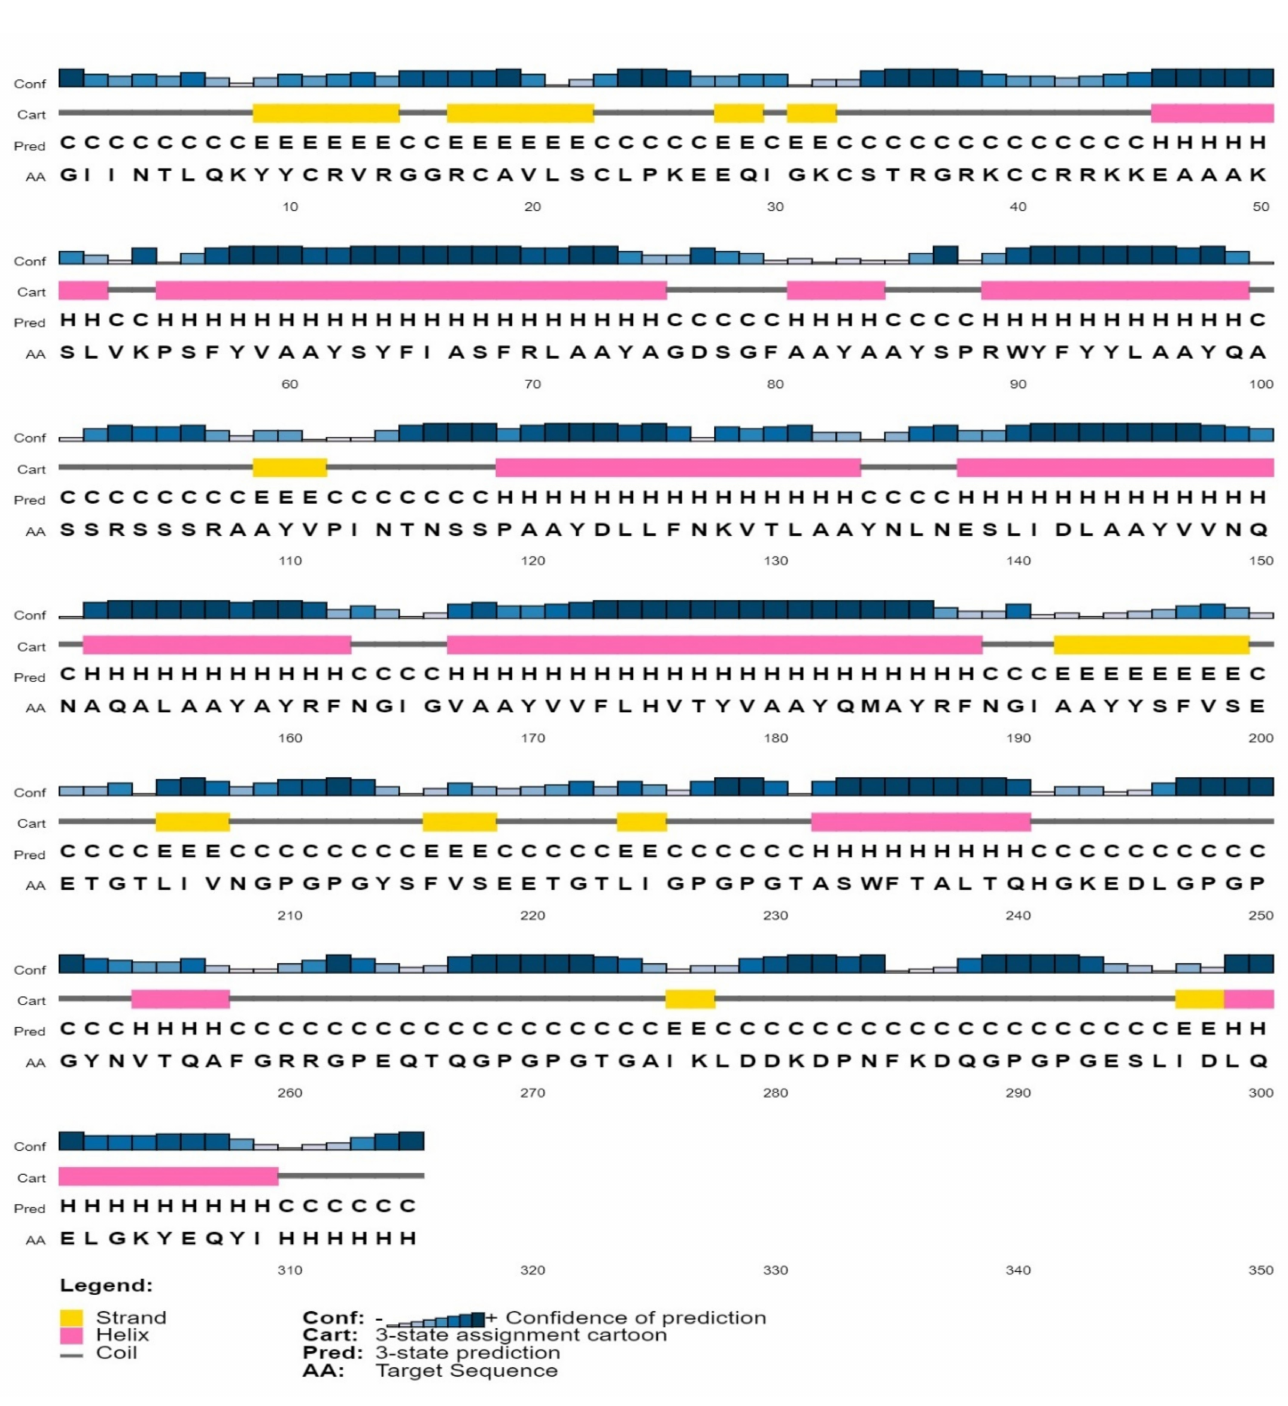
Figure 3. Secondary structure prediction of the vaccine construct. The color-coding of different regions is explained in the legend within the figure. For secondary structure prediction, C, H, and E symbols indicate the coil, helix, and strand regions,